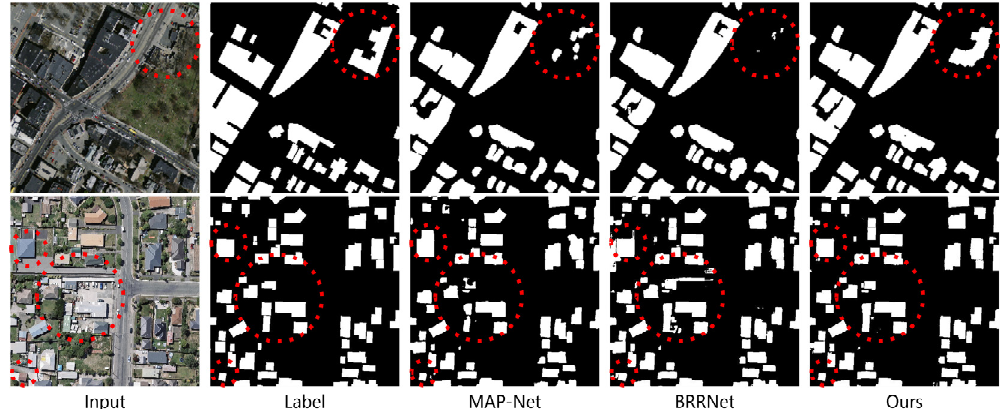
Figure 1. Typical building extraction results by some existing methods in the spectrum confusion area.